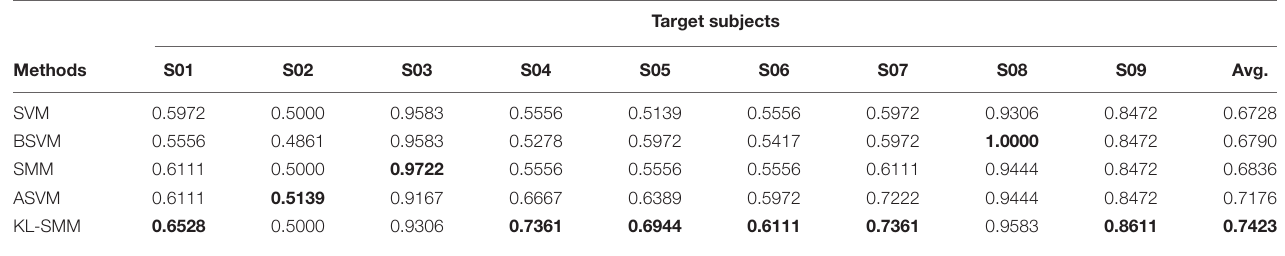
TABLE 1 | Comparison of ACC using 14 labeled target EEG data in Exp.1